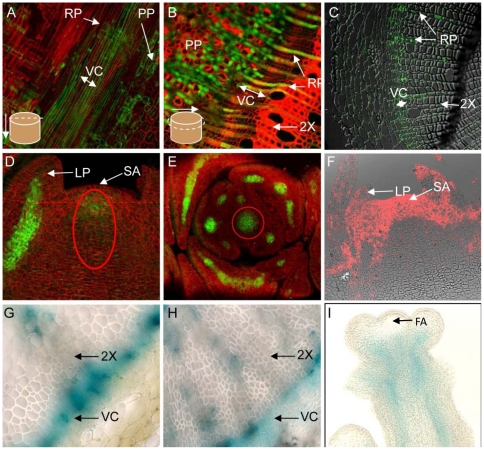
SHR transcriptional activity revealed by promPtSHR1::GFP and promAtSHR::GUS expression pattern in poplar (T89) and Arabidopsis (Col0), respectively.(A) Tangential longitudinal section through fully elongated, rapidly growing poplar stem; (B) Transverse section through rapidly growing poplar stem; (C) Transverse section through poplar stem showing immunofluorescent labeling (green signal) indicating PtSHR1 epitopes; (D) Radial longitudinal section through poplar apex; (E) Transverse section through apex (taken at position of dotted line in D); (F) Radial longitudinal section through apex showing immunofluorescent labeling (red signal) indicating PtSHR1 epitopes; (G) Transverse section through base of Arabidopsis floral stem; (H) Transverse sections though hypocotyl of flowering Arabidopsis plant; (I) Radial longitudinal section through Arabidopsis floral stem. Oval in (D) showing equivalent cells in circled section in (E). Cell walls in (A), (B), (C) and (D) were counterstained with calcofluor white. RP, ray parenchyma; PP, phloem parenchyma; VC, vascular cambium; 2× secondary xylem; LP, leaf primordium; SA, shoot apex; FA, floral apex.